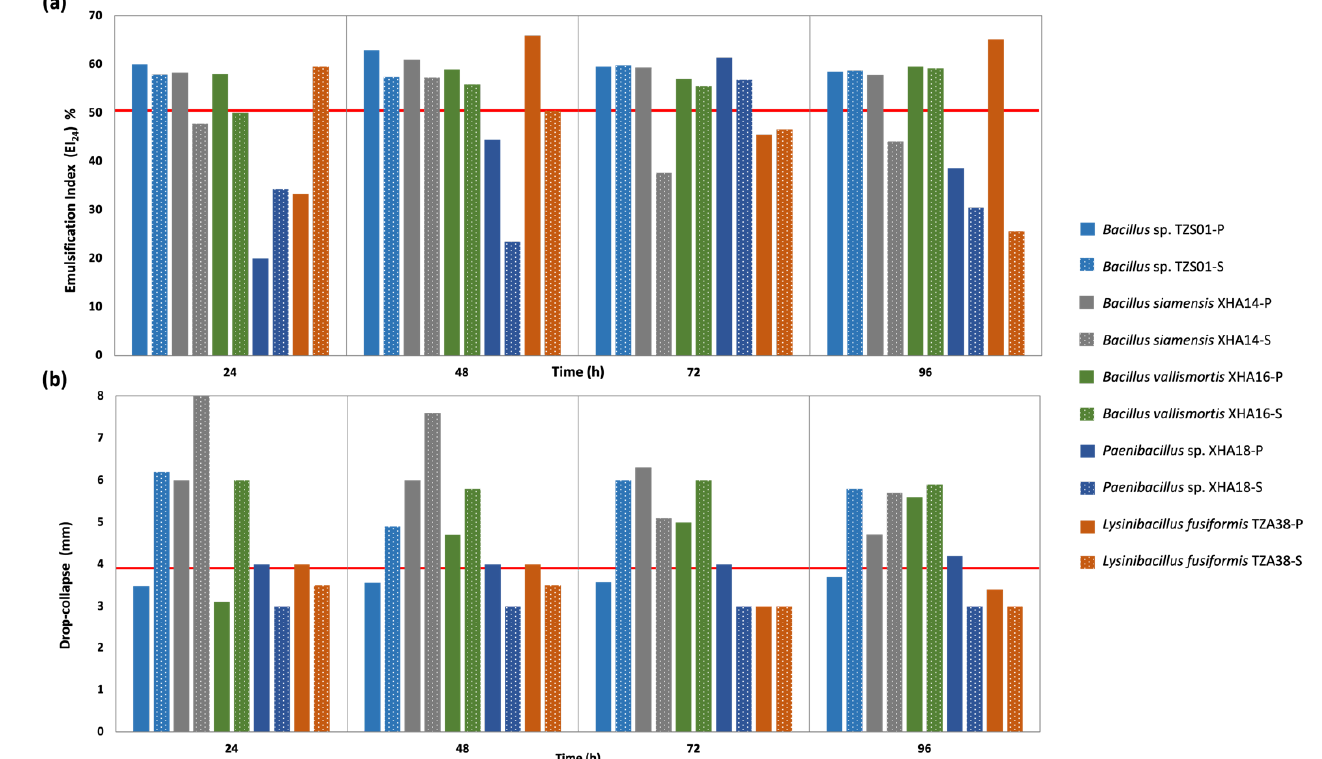
Figure 2. ( a ) Bioemulsifying and ( b ) biosurfactant activity of bacteria strains from sinkholes at different times in planktonic and sessile cultures. Solid bars are planktonic culture (P), dotted bars are sessile culture (S).